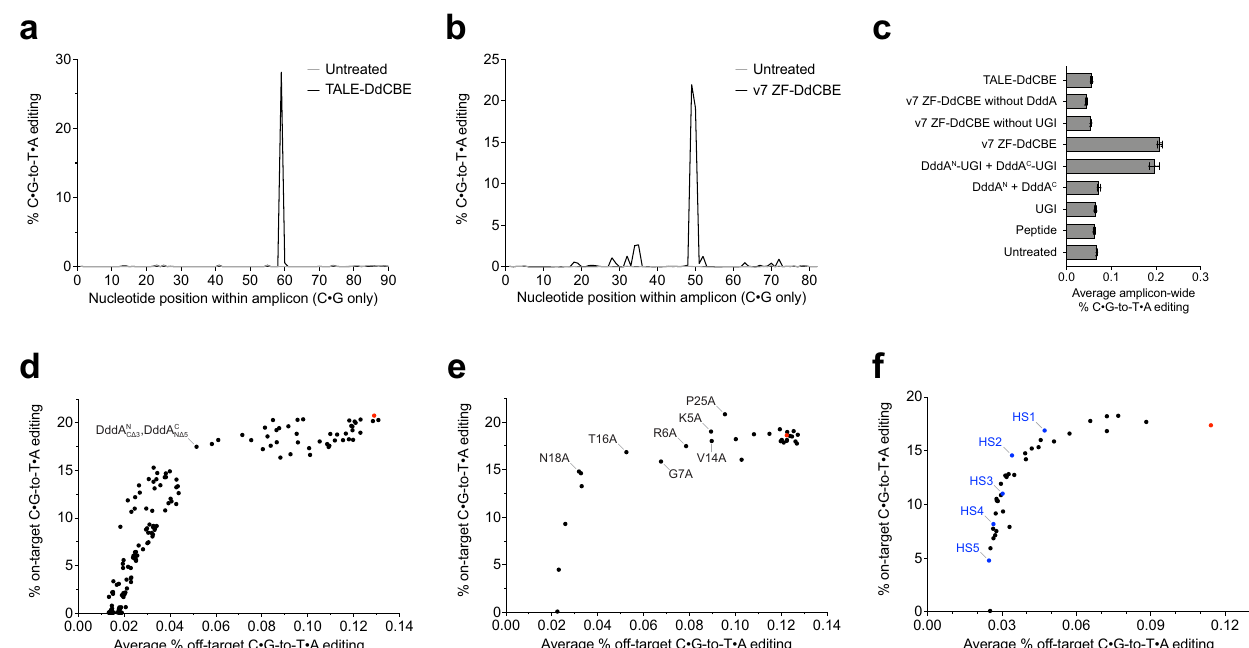
Fig. 3 | High-speci fi city ZF-DdCBE variants reduce mitochondrial off-target editing. a Mitochondrial DNA base editing ef fi ciencies within amplicon ND4 of HEK293T cells treated with ND4-DdCBE. b Mitochondrial DNA base editing ef fi - ciencies within ampliconATP8of HEK293Tcellstreated withv7 ZF-DdCBEpair R8- 3i-ATP8+4-3i-ATP8. c Off-target editing ef fi ciencies within mitochondrial off-target ampliconND5.1ofHEK293TcellstreatedwithND4-DdCBE,v7ZF-DdCBEpairR8-3i- ATP8+4-3i-ATP8, or individual components of the v7 ZF-DdCBE architecture. d – f On-target and average off-target editing ef fi ciencies within amplicon ATP8 of HEK293T cells treated with canonical v7 ZF-DdCBE pair R8-3i-ATP8+4-3i-ATP8